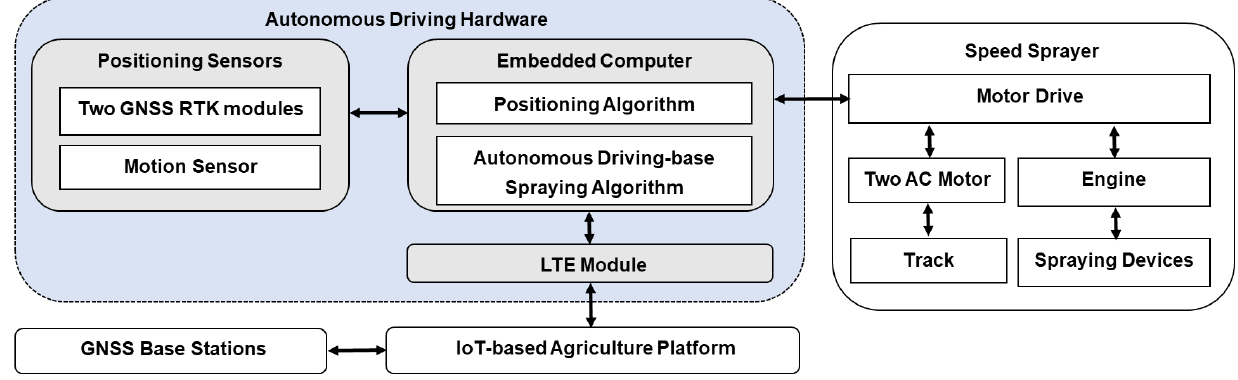
Figure 1. Overall architectural design of an autonomous driving-based spraying work system.